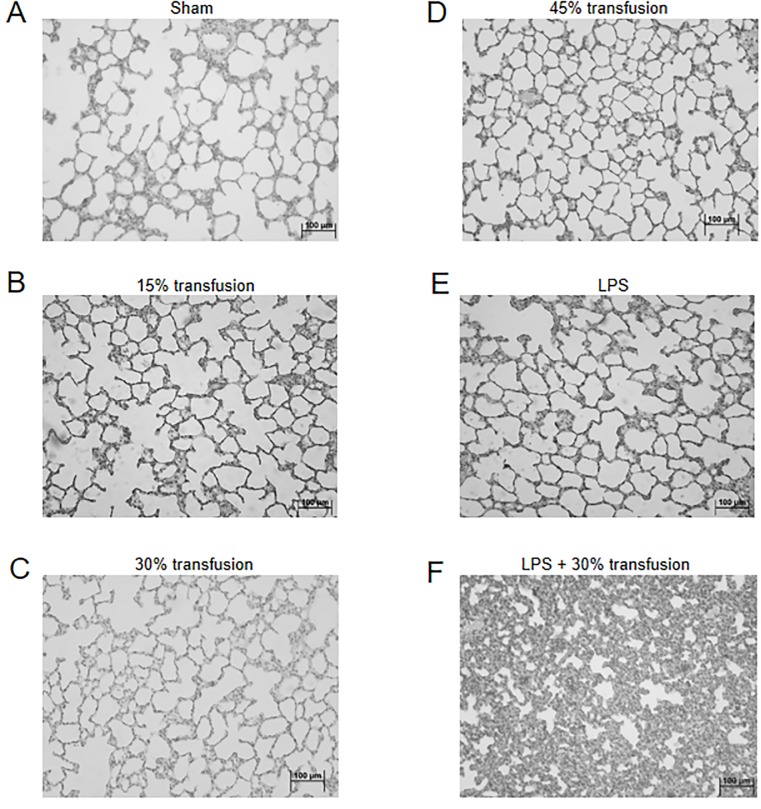
LPS+30% transfusion results in acute lung injury.Representative histology (H&E stain) of rat lungs. (A) Sham control. (B) 15% transfusion of human erythrocytes. (C) 30% transfusion. (D) 45% transfusion. (E) LPS only. (F) LPS+30% transfusion. Animals receiving transfusion in the absence of LPS and LPS alone demonstrated normal lung architecture as seen in sham treated animals whereas animals receiving LPS+30% transfusion showed severe neutrophil infiltration and thickening of the alveolar walls. Bar represents 100 μm. Tissues were observed with a microscope (BX50, Olympus) at a magnification of 20X at room temperature. Images were acquired with a digital camera (DP70, Olympus).